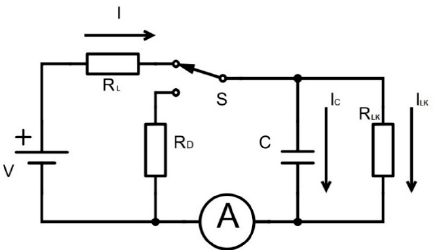
Figure 7. Theoretical RC charge circuit setup. The ideal model that simulates the electrical behavior of the capacitor ( C ) in the charging mode has been obtained by adding a parallel resistance, or leakage resistance ( R LK ), in the capacitor’s branch. The intensity ( I ) flowing through the load resistance ( R L ) would be divided into two, the one that circulates through the capacitor itself ( I C ), and the one circulating through the leak resistance ( I LK ). Note that this figure is a schema because the real circuit used is the one represented in Figure